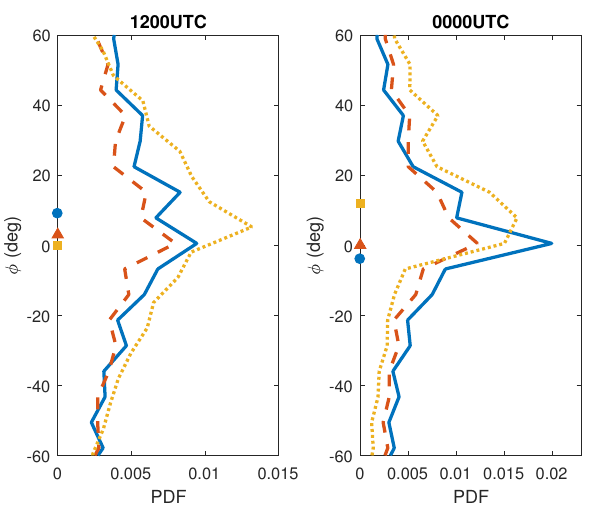
Figure 9. Probability Density Function (PDF) of the wind turning angle estimated from the 1200UTC soundings (left panel) and the 0000UTC soundings (right panel) with the PBLH estimated using the gradient method. Shown are the PDFs for Athens (solid line), Thessaloniki (dashed line) and Heraklion (dotted line) along with the corresponding median of the distributions for Athens (circles), Thessaloniki (triangles) and Heraklion (squares).